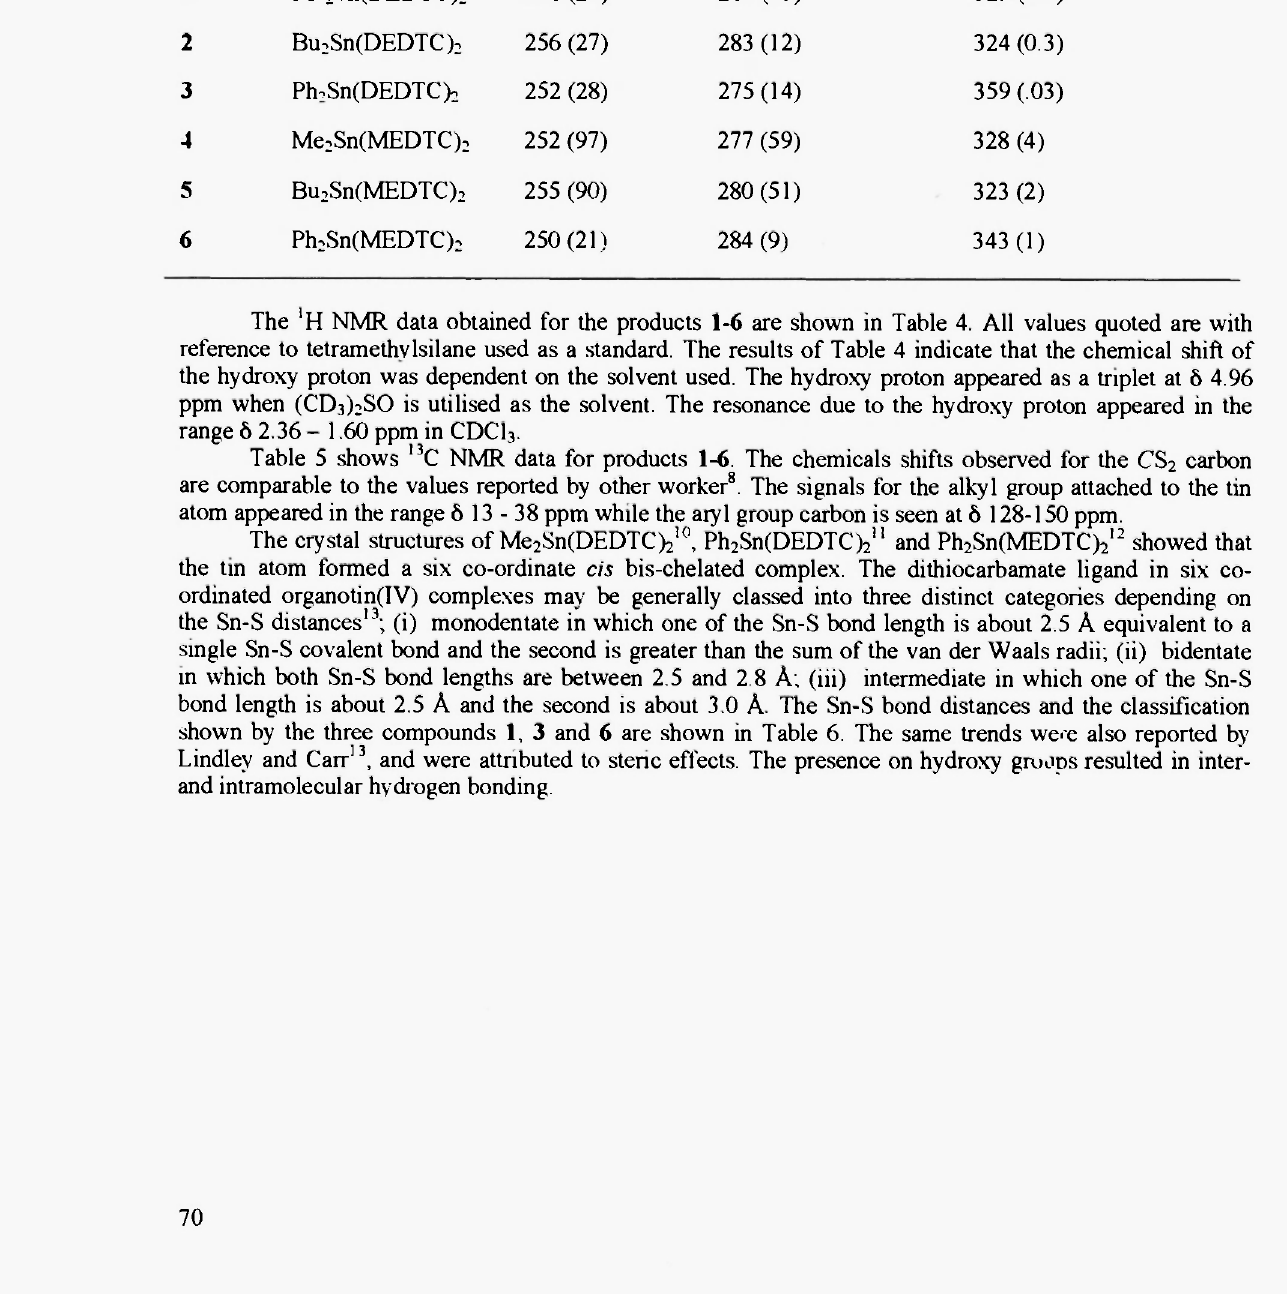
Table 3. Important UV absorption bands (nm) and ε (10 3 cm"' mol"' L)